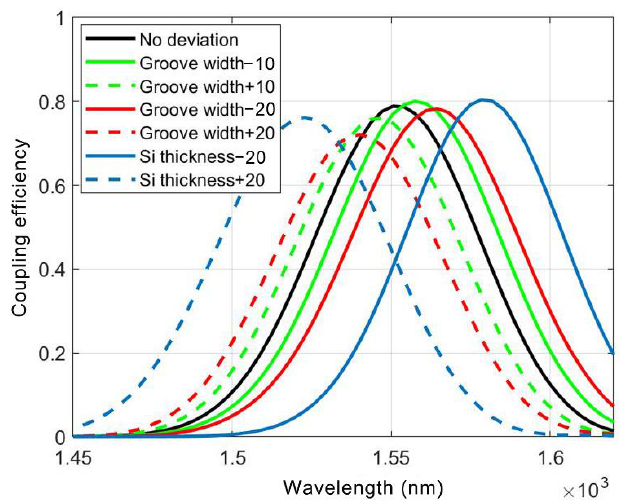
Figure 8. Analysis on the fabrication tolerance of the proposed grating couplers for the silicon HPWs with a bottom metal layer.